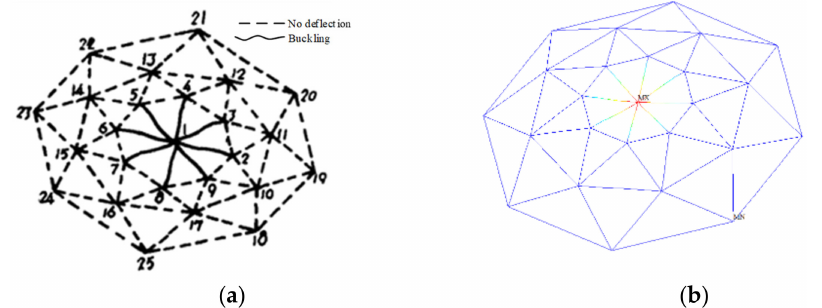
Figure 27. Failure modes of the single-layer reticulated shell: ( a ) Test [40]; ( b ) FEA. (Reprinted with permission from ref. [40], Copyright 1995 Yongfeng